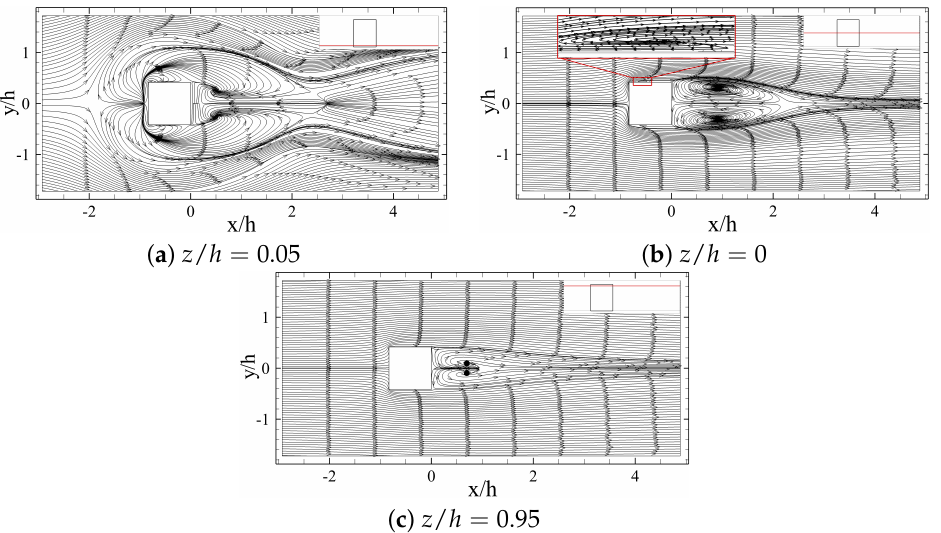
Figure 18. The top ( xy -plane) view of the wake structure of the square prism. Figure 19 shows the vorticity contours in the near wake region of the prisms. The larger magnitudes of spanwise and streamwise components of vorticity in the wake region of the square prism can lead to larger streamline curvatures. This provides further evidence of the stronger entrainment in the wake of the square prism compared to the long prism. The separated shear layer from the leading edge exhibits a large vorticity magnitude for both prisms. In the case of the square prism, the leading edge separated flow impacts the wake structures through what can be described as flow entrainment. However for the long prism, the reattachment of the flow on the upper and side faces prevents any entrainment mechanism. The presence of counter-rotating vortices in two sides of the prism implies that Kármán type vortices are suppressed by the upwash and downwash flow in both cases, due to the small aspect ratio of the